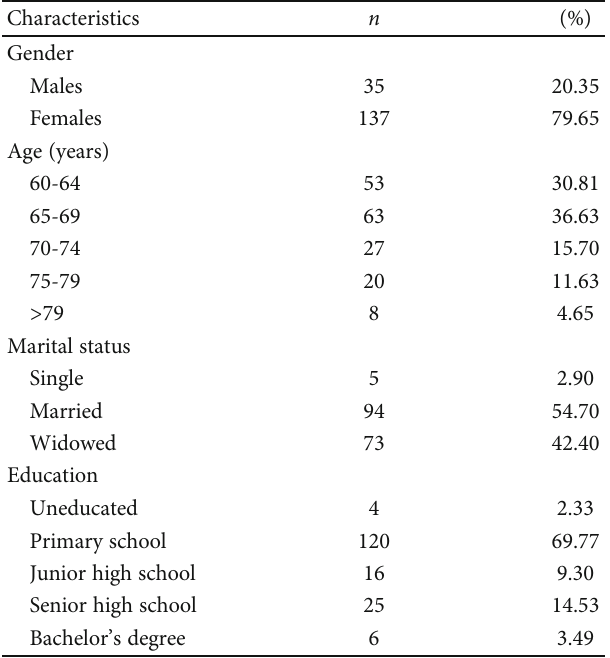
Table 1: Characteristics of the participants ( n = 172